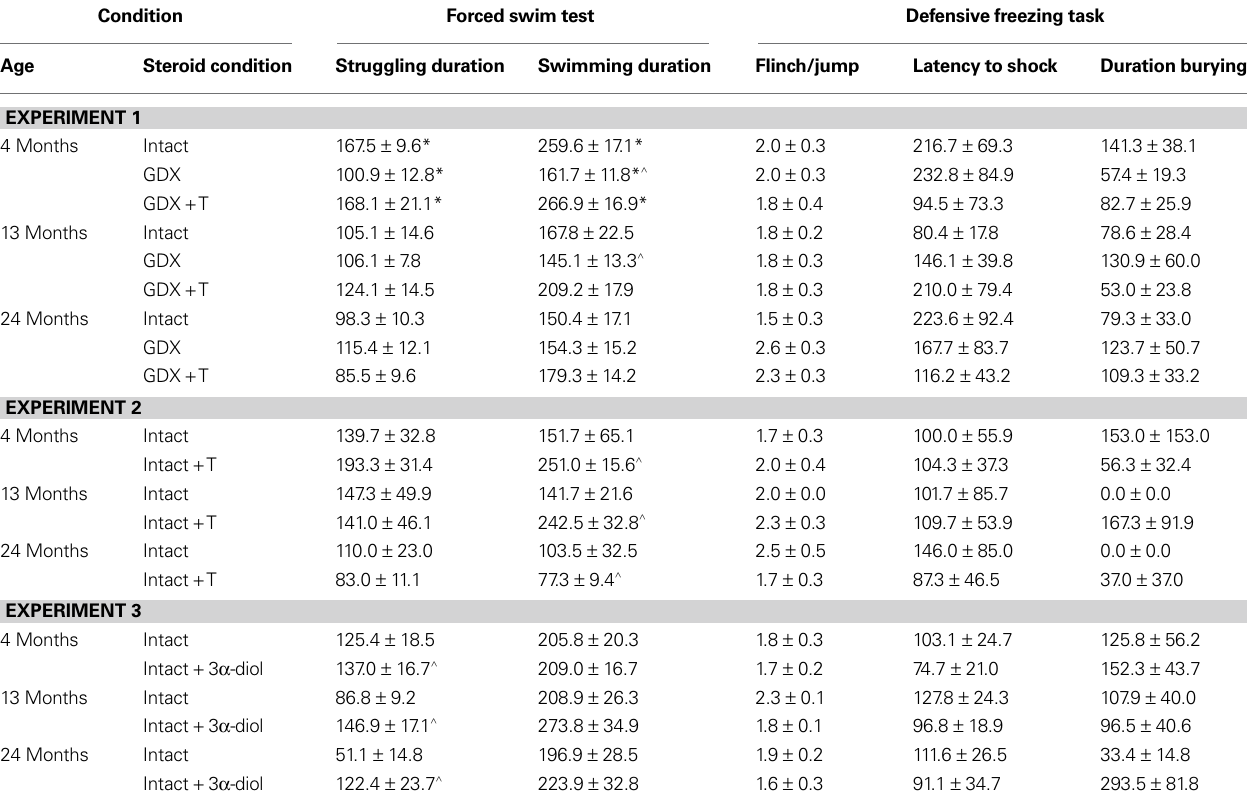
Table 3 | Motor and shock response-behavior of 4-, 13-, and 24-month-old gondally-intact (intact), gonadectomized (GDX), or GDX and T-replaced (GDX + T; Experiment 1), intact or intact and T-administered (Experiment 2), and intact or intact and 3 α -diol administered (Experiment 3) rats in the forced swim (struggling and swimming duration) and defensive freezing (Flinch/jump, latency to shock, duration burying)